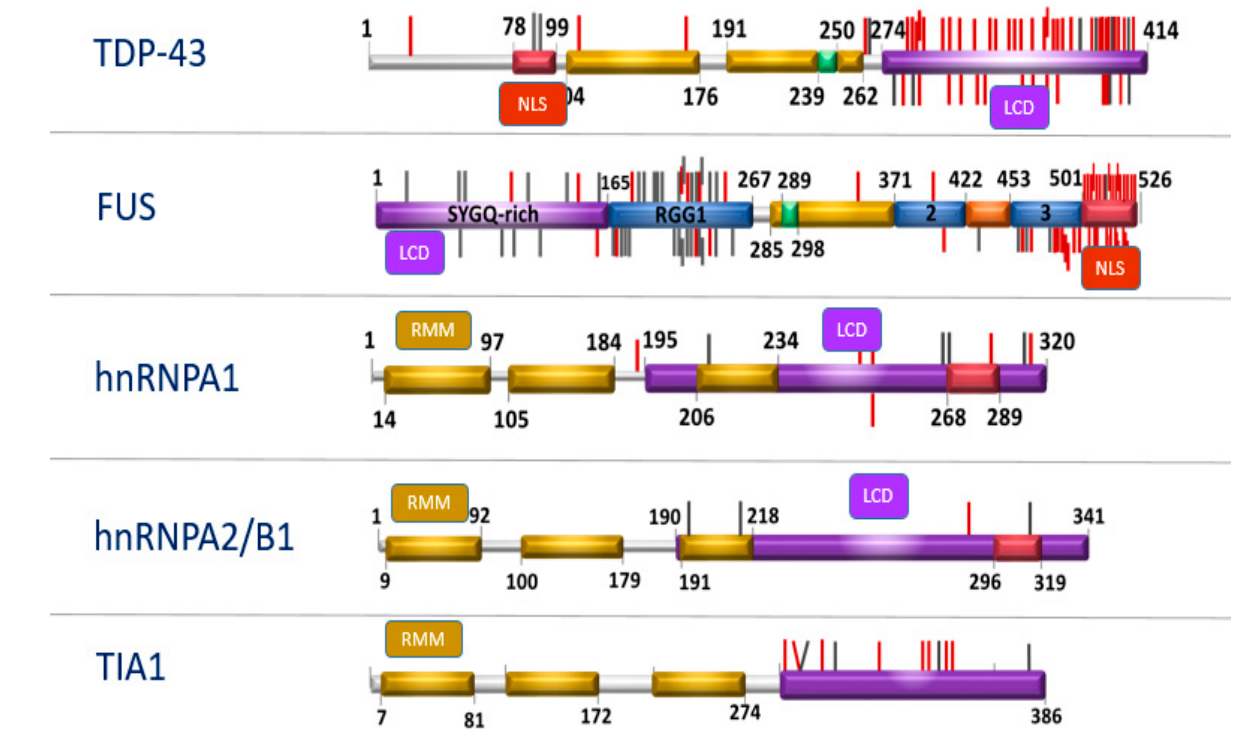
Figure 1. Structure of RNA-binding protein (RBP) genes.